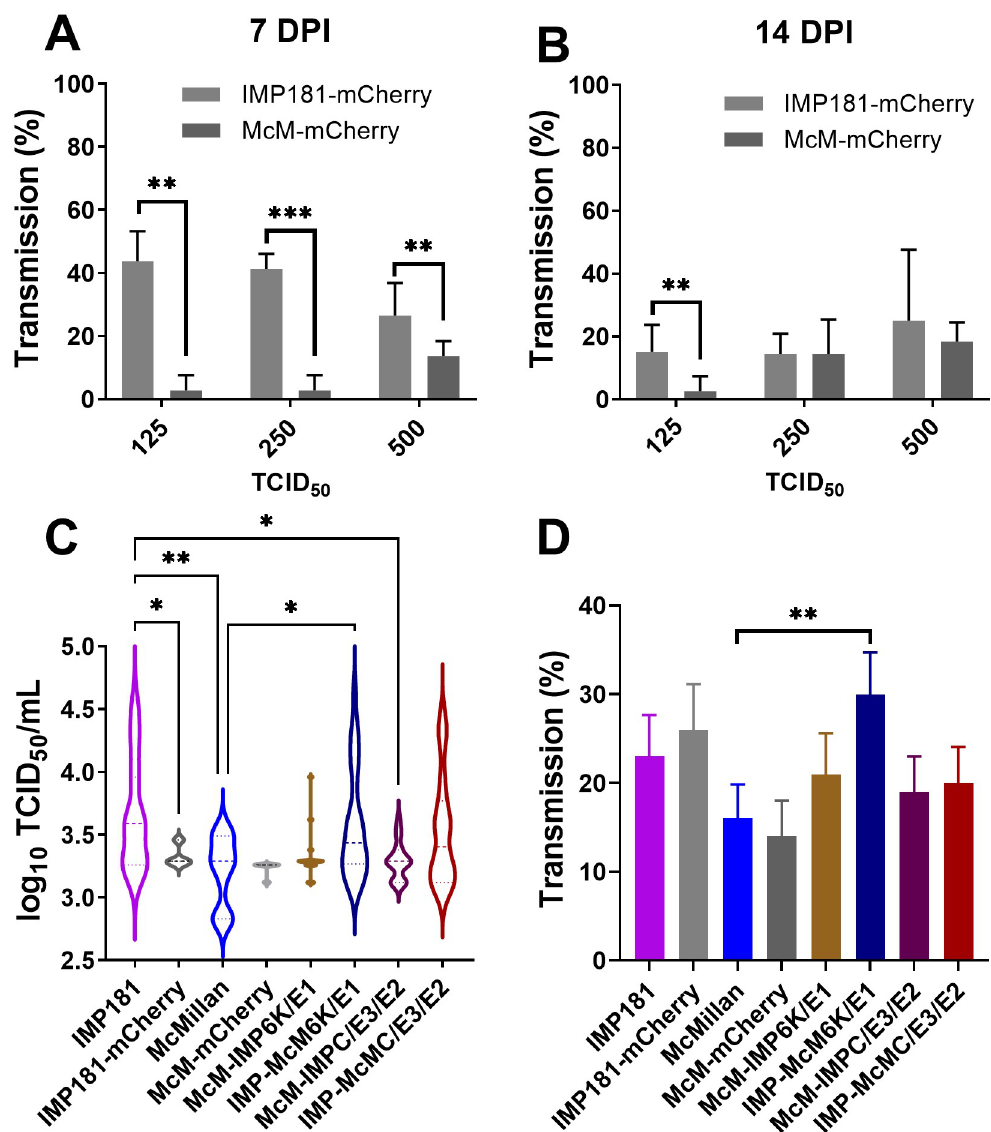
or 500 TCID 50 . Infectious viral titers were also compared between IMP181 and McMillan derived viruses in saliva collected at 7 days post-injection with 500 TCID50 with IMP181 6K/E1 genes associated with an increase in expectorated virus (C). Transmission rates were also assessed for IMP181 and McMillan derived viruses